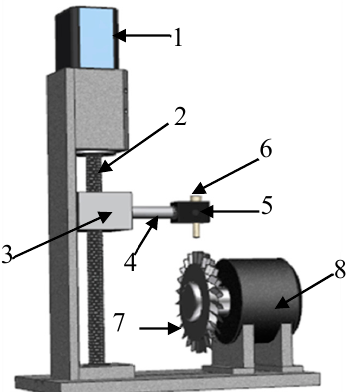
Figure 8. Calibration setup. 1-stepping motor, 2-screw, 3-slider, 4-spindle extension, 5-clip, 6-sensor,